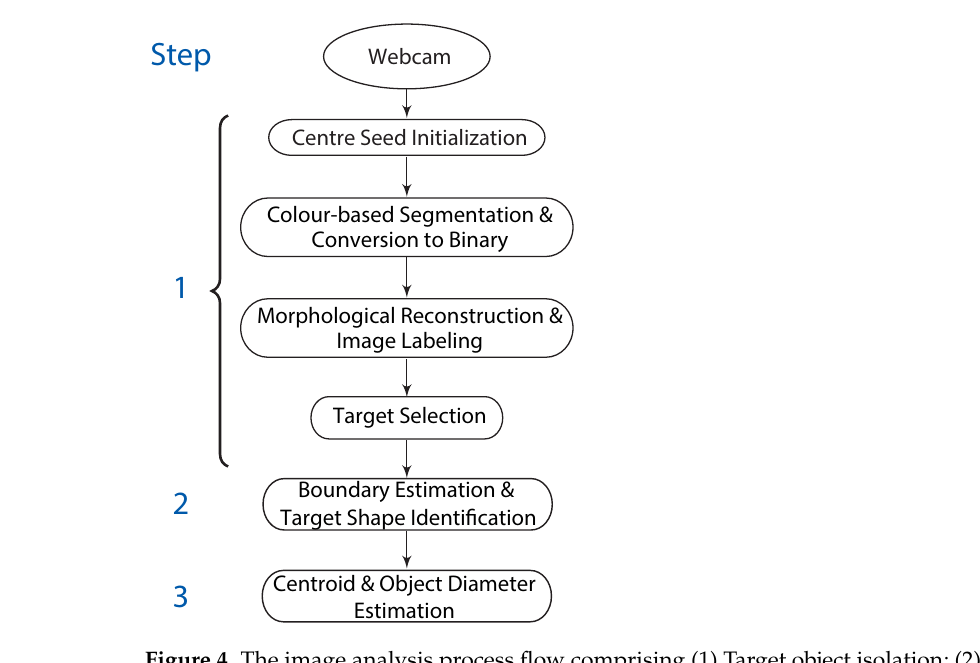
Figure 4. The image analysis process flow comprising (1) Target object isolation; (2) The signature model extraction; and (3) Object centroid and diameter